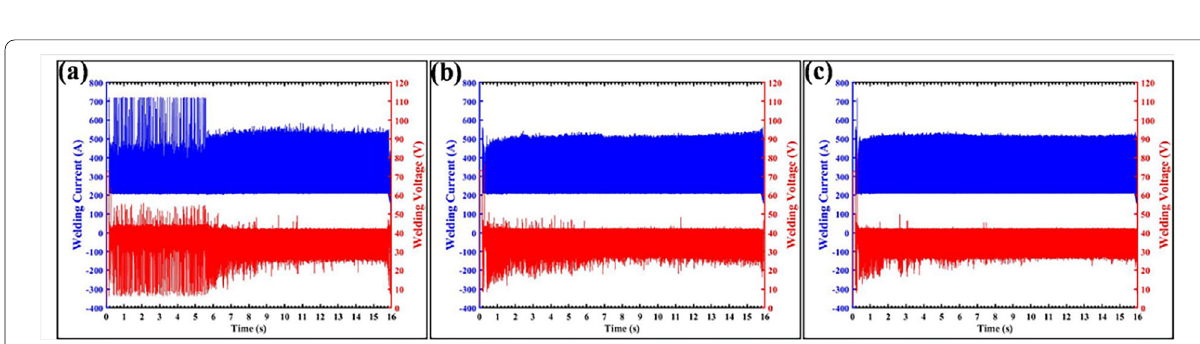
Figure 11 Current and voltage waveforms under shielding of ( a ) Ar